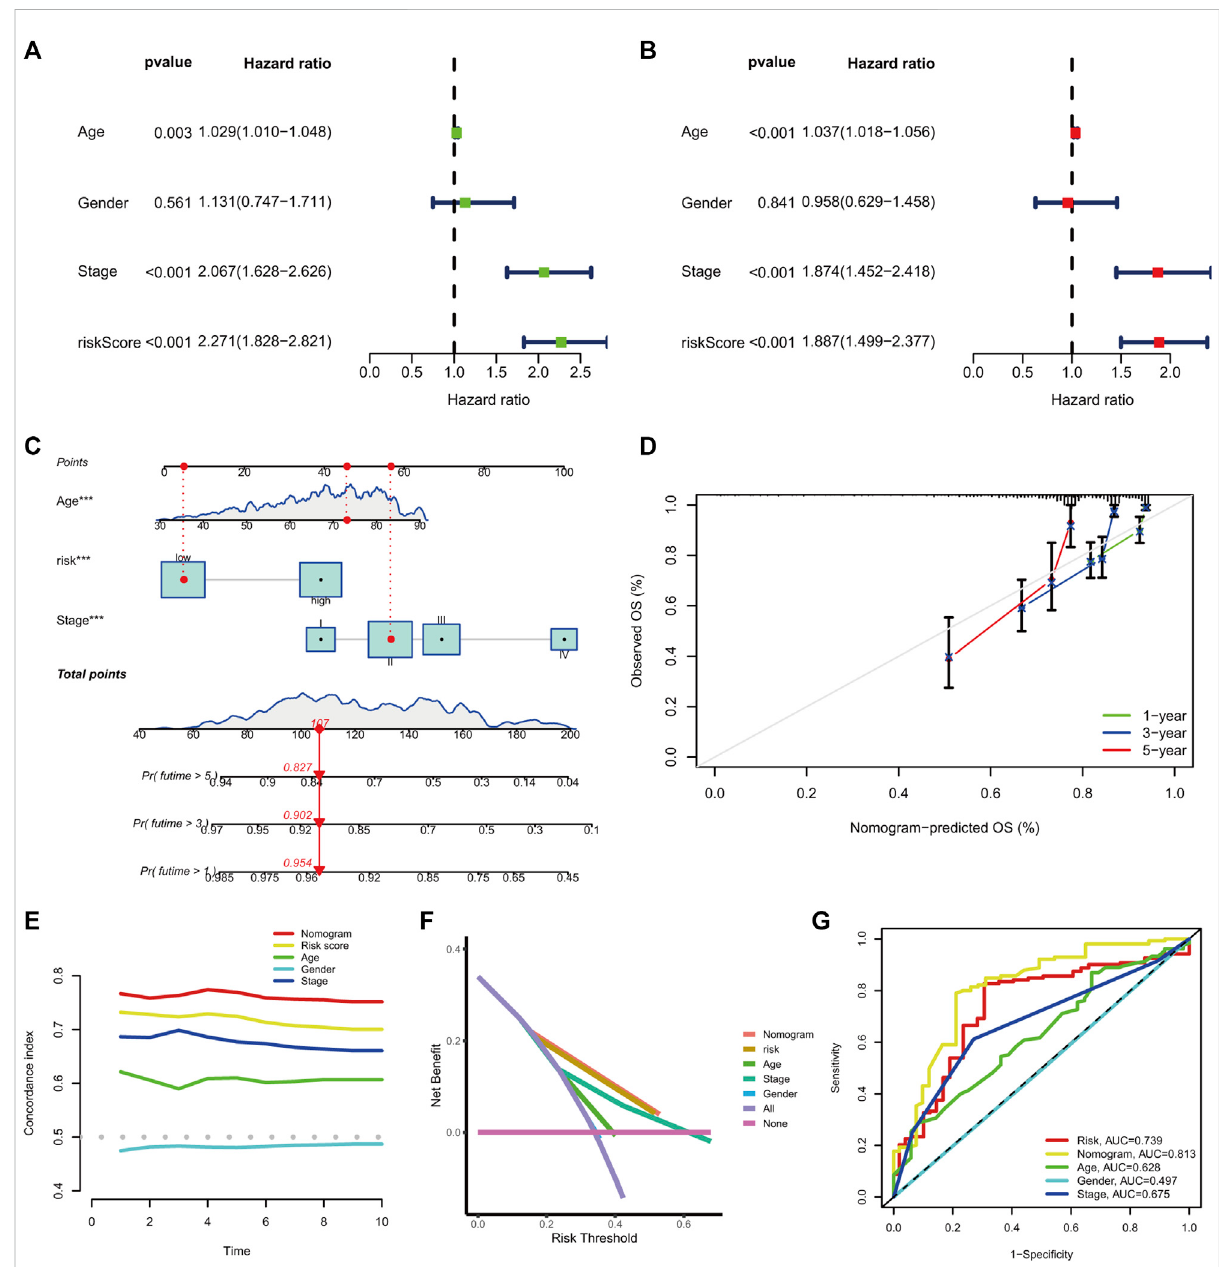
FIGURE 6 The prognostic nomogram generation and validation. (A) Univariate hazard analysis of the prognostic score and clinical baseline features. (B) The multivariate hazard analysis of the prognostic score and clinical baseline features. (C) Establishment of the prognostic nomogram. (D) The calibration curves of the nomogram signature at 1-, 3-, and 5-year OS. (E) C-index of the prognostic nomogram, prognostic signature, and clinical baseline features from 1 to 10 years. (F) DCA curves for prognostic nomogram, prognostic signature, and clinical baseline features. (G) ROC curve at 5 years for prognostic nomogram, prognostic signature, and clinical baseline